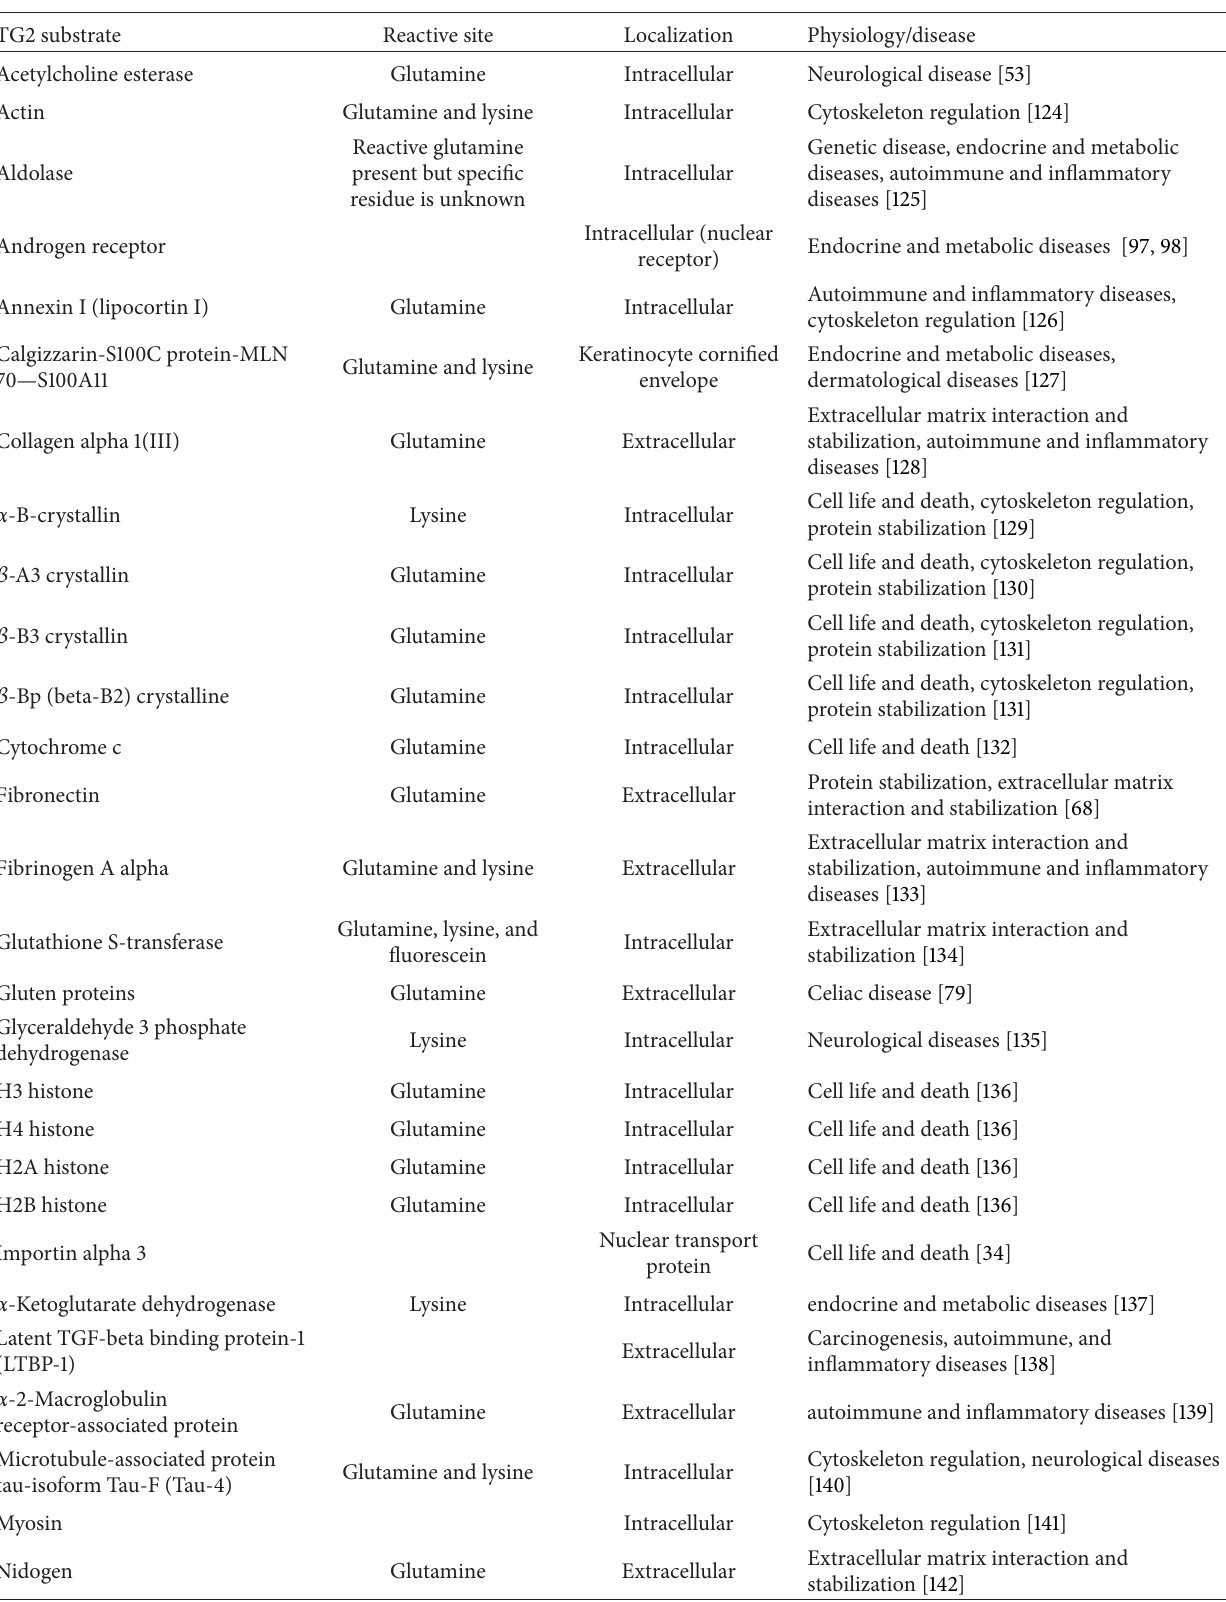
Table 2: Transglutaminase 2 substrates, reactive sites, cellular localizations, and possible involvement in human